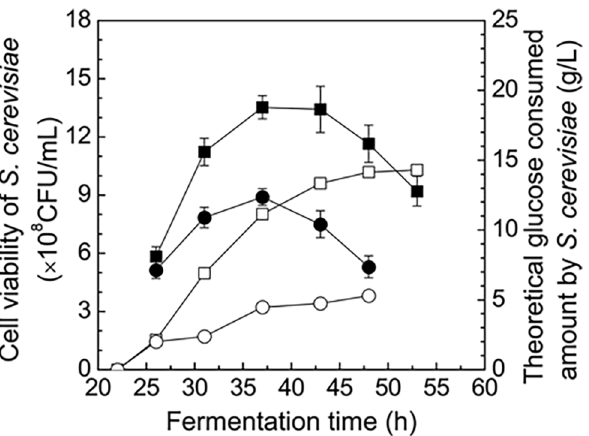
Fig 6. S . cerevisiae cells viability and theoretical glucose amount consumed by S . cerevisiae in the proposed co-culturing system. (cid:6) & ● : cell viability of S . cerevisiae in the co-culturing system without/with butyrate addition; □ & ■ : theoretical glucose amounts consumed by S . cerevisiae in the co-culturing system without/with butyrate addition.